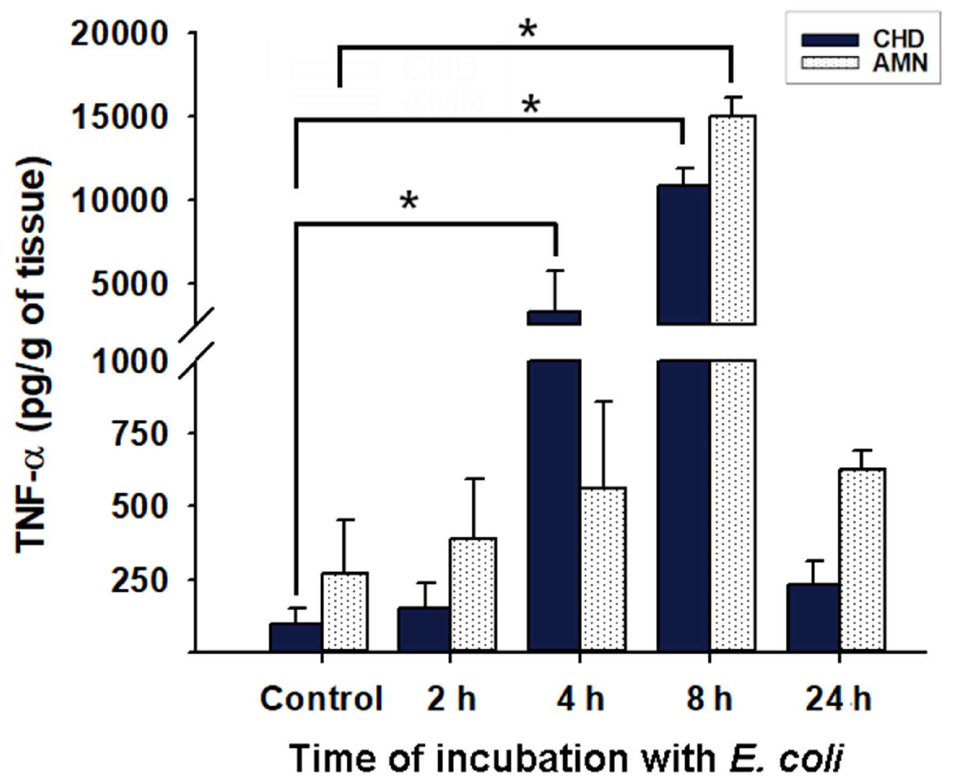
Figure 2. Pattern of TNF-α secretion into the culture medium from the chorioamniotic mem- branes infected with Escherichia coli . An inoculum of 1 × 10 5 CFU/mL E. coli was used to infect the CHD compartment. Tissue culture proceeded for 24 h, and an aliquot of the medium was used to assess the TNF-α concentration at each follow-up time point (control, 2, 4, 8, and 24 h). The data are presented as means ± SD. n = 3 independent experiments in duplicate. * p < 0.05. AMN: Amnion. CHD: Choriodecidua.